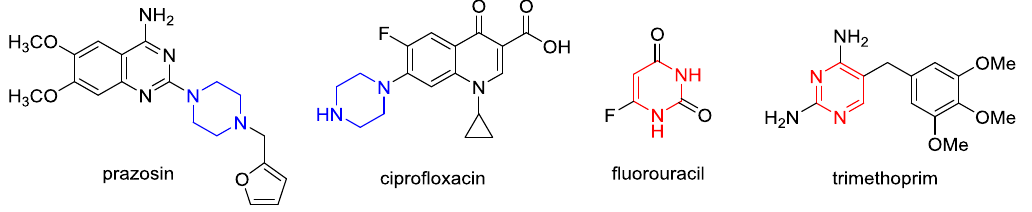
Figure 1. Piperazine- and pyrimidine-containing drugs.